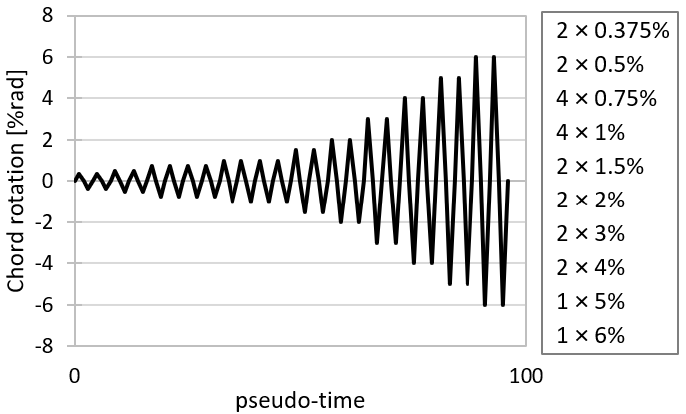
Figure 4. The cyclic loading protocol. Table 1. Columns with simplified boundary conditions.